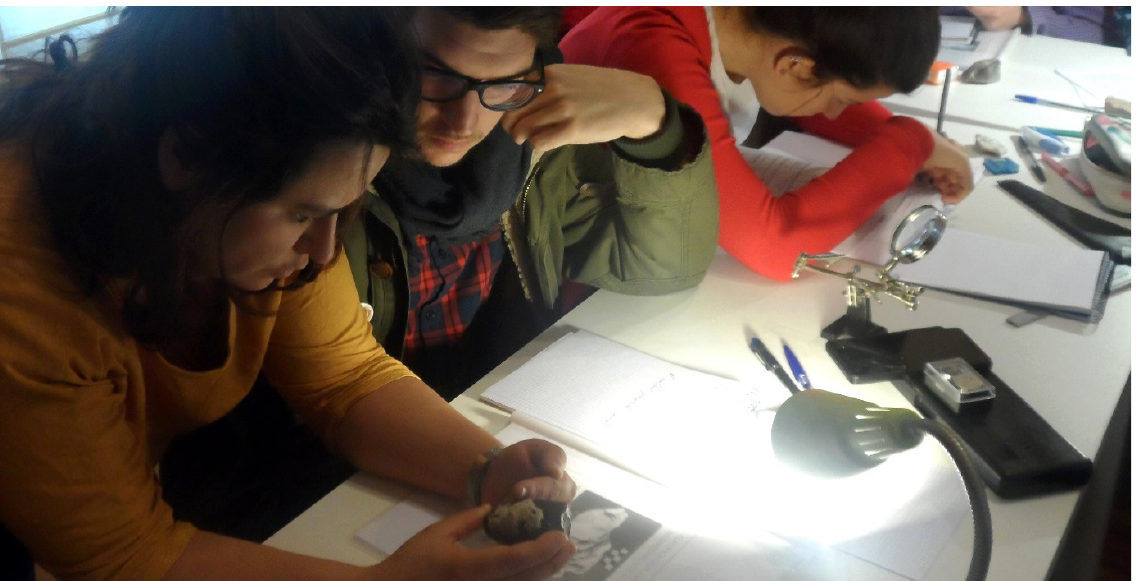
Figure 1. Recognizing the attributes of a lithic core. (Photograph provided by Dibujantes de Arqueología, 2015.)